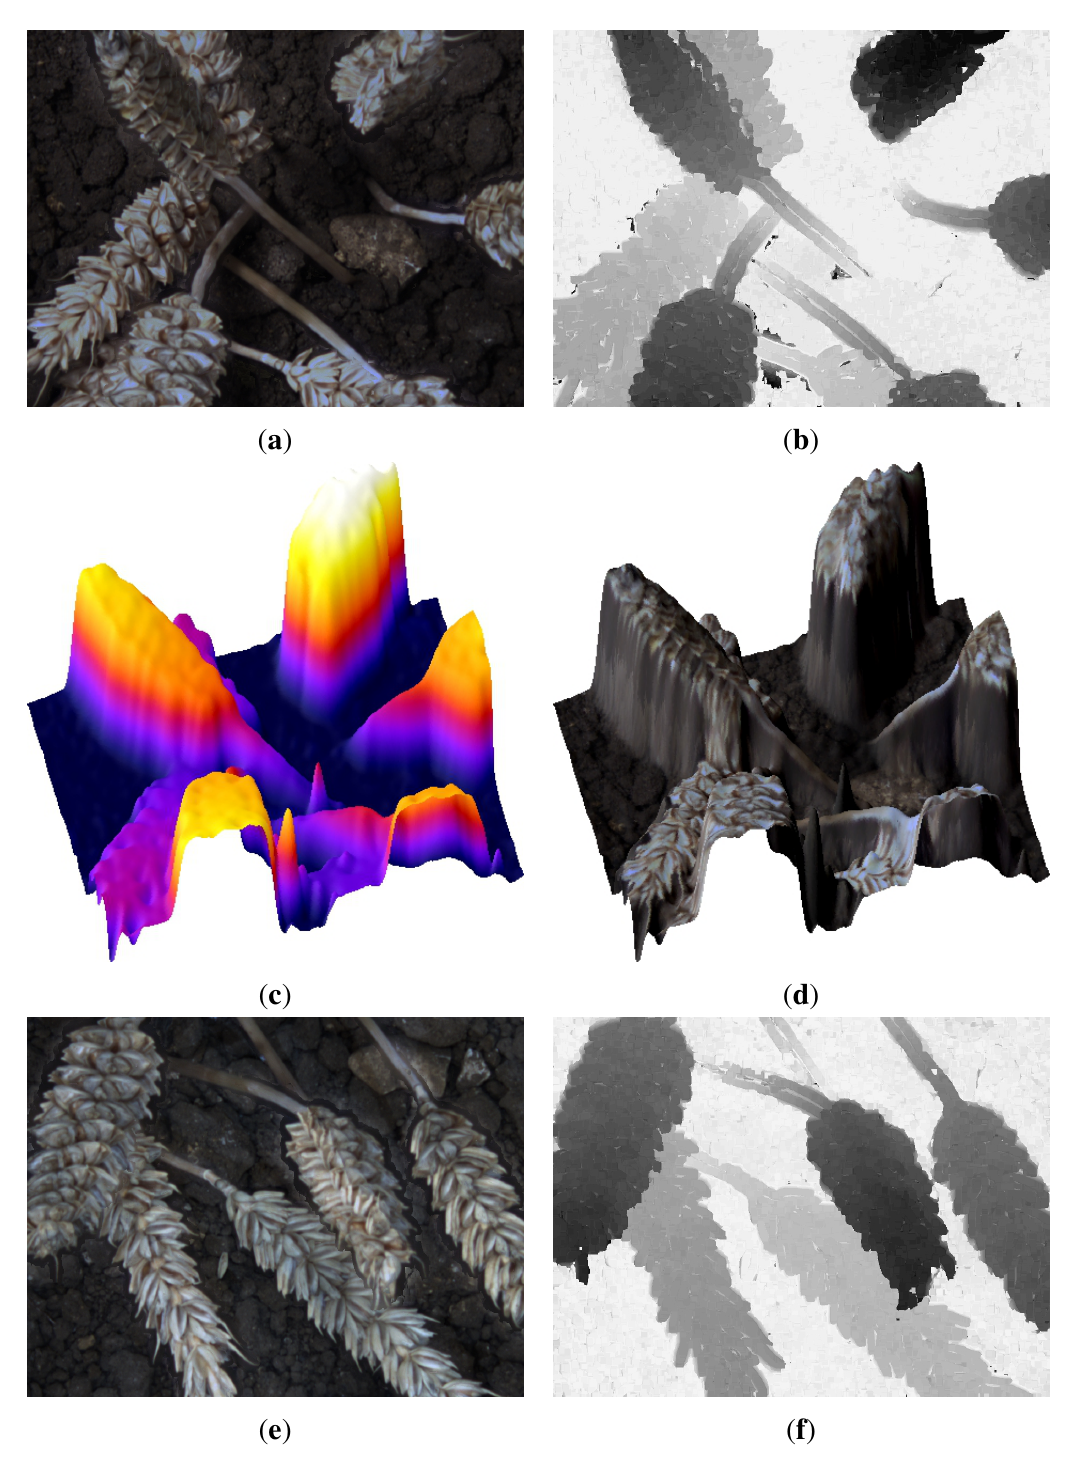
Figure 6. Merged images of two different sequences ( a , e ), associated depth maps ( b , f ) and 3D visualizations with ( d , h ) and without ( c , g ) texture